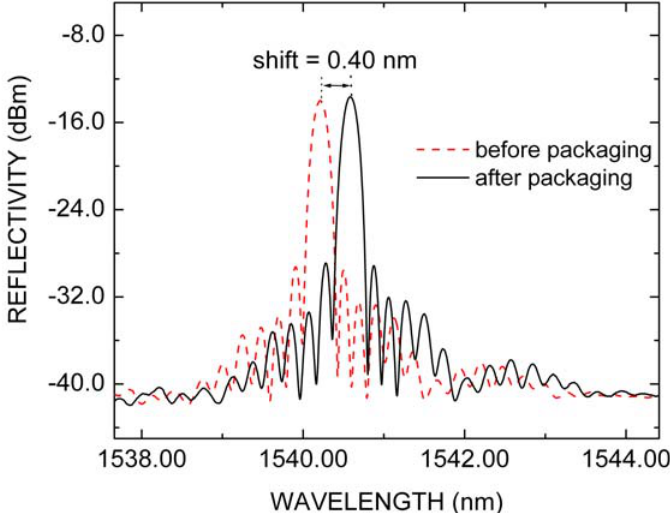
Figure 2. FBG2 reflection spectrum before (red dashed line) and after (black solid line) packaging.